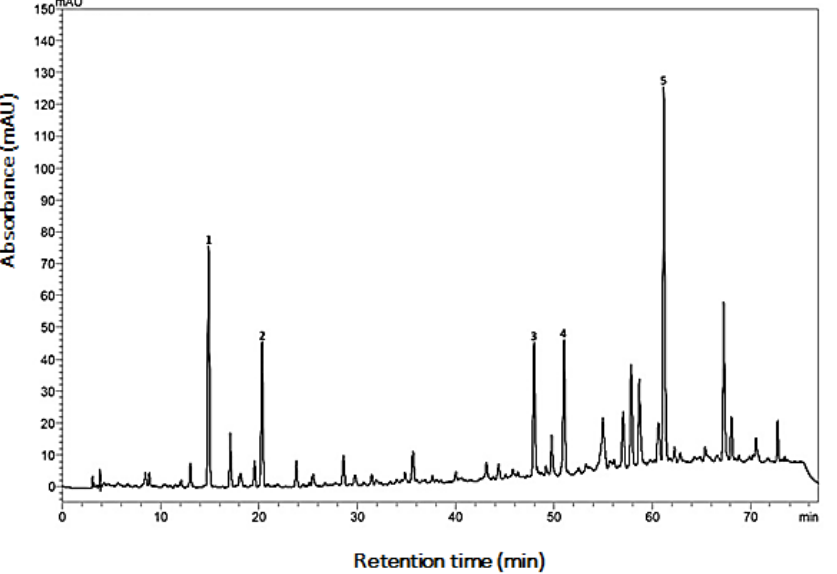
Figure 1. Chemical fingerprint obtained using C18-RP column for BGP-ExtAq. Peak 1 = caffeic acid, peak 2 = p-coumaric acid, peak 3 = drupanin, peak 4 = kaempferide and peak 5 = Artepillin C.